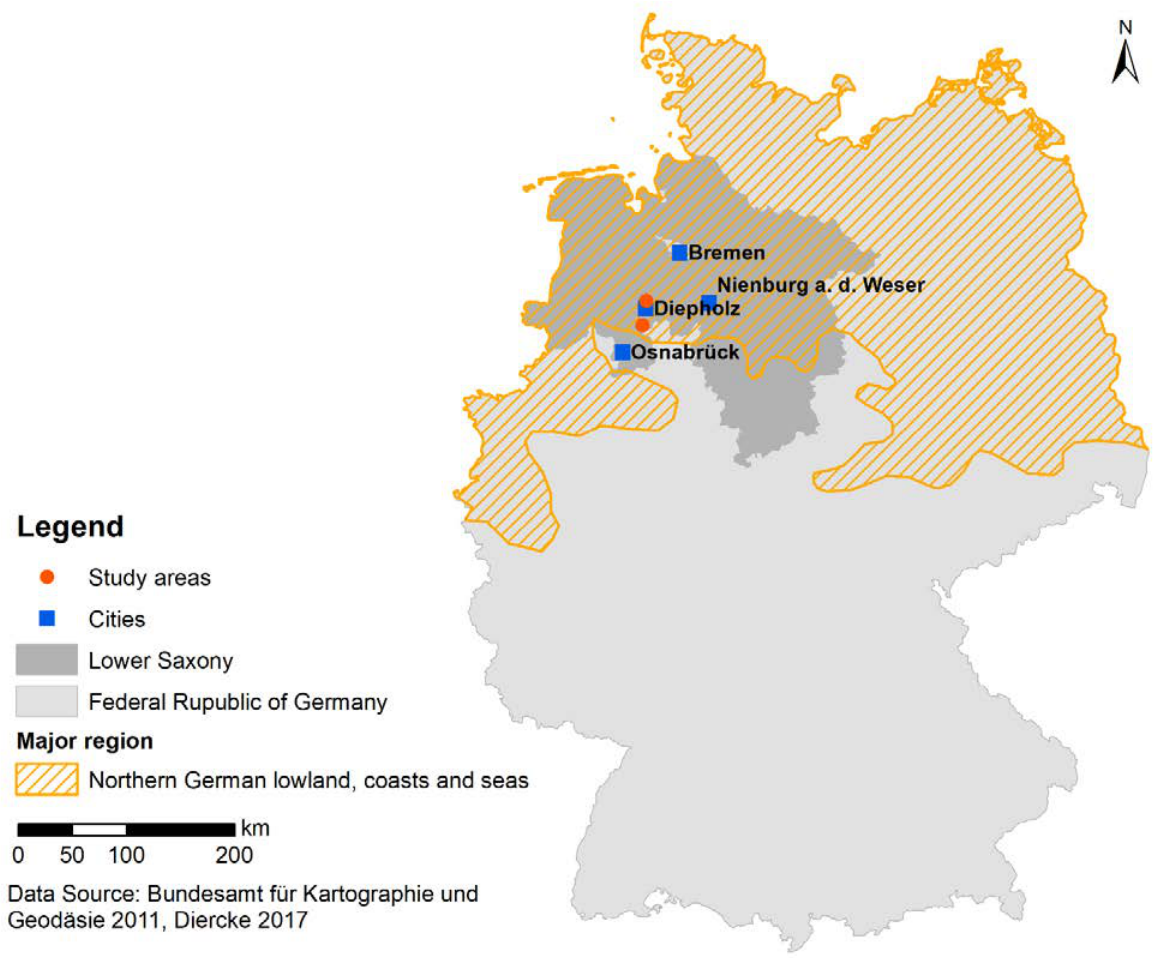
Figure 4. Location of the study areas in Germany and in their physio-geographical